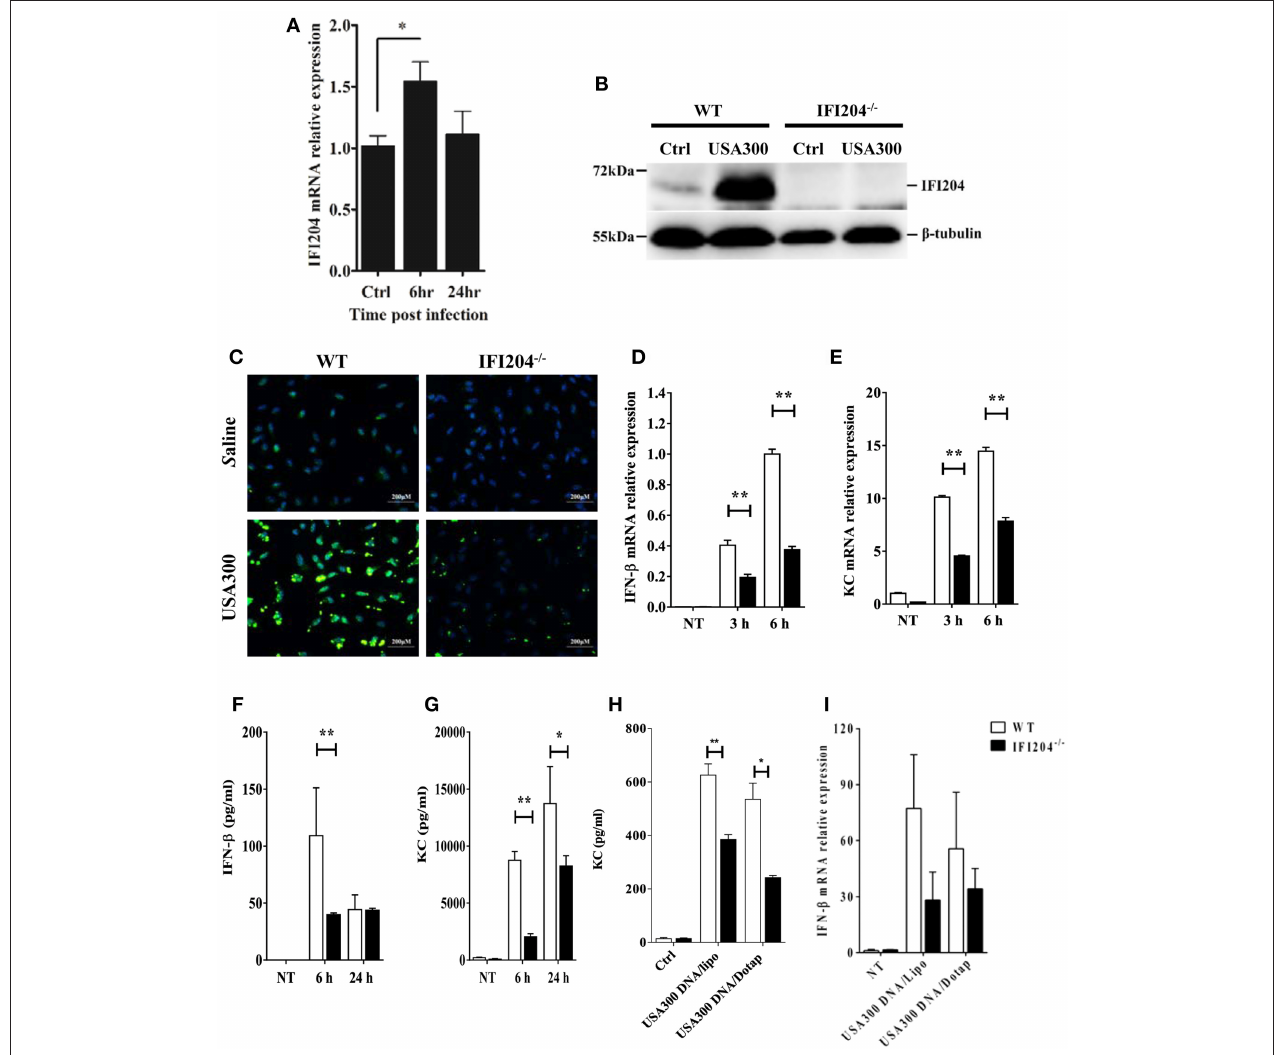
FIGURE 4 | IFI204 is upregulated and promotes proinflammatory cytokines production in BMDM following Staphyloccoccus challenge. WT and IFI204 − / − BMDM were untreated or exposed to Staphylococcus at a MOI of 1:50 for indicated time. (A) IFI204 mRNA levels were measured by qRT-PCR. IFI204 protein in cells at 24 hpi was measured by Western blotting (B) and immunofluorescence microscopy (C) . Shown are representative images from two independent experiments. (D–G) Protein and/or mRNA levels of IFN- β and KC in BMDM were examined at the indicated time after infection. (H,I) WT and IFI204 − / − BMDM were transfected with Staphylococcus -derived genomic DNA using Lipofectamine 2000 or DOTAP. KC and IFN- β levels were quantified by ELISA or qRT-PCR. Data shown is representative of at least three independent experiments. All data are shown as mean ± SEM. Student’s t -test was performed. * p < 0.05; ** p <